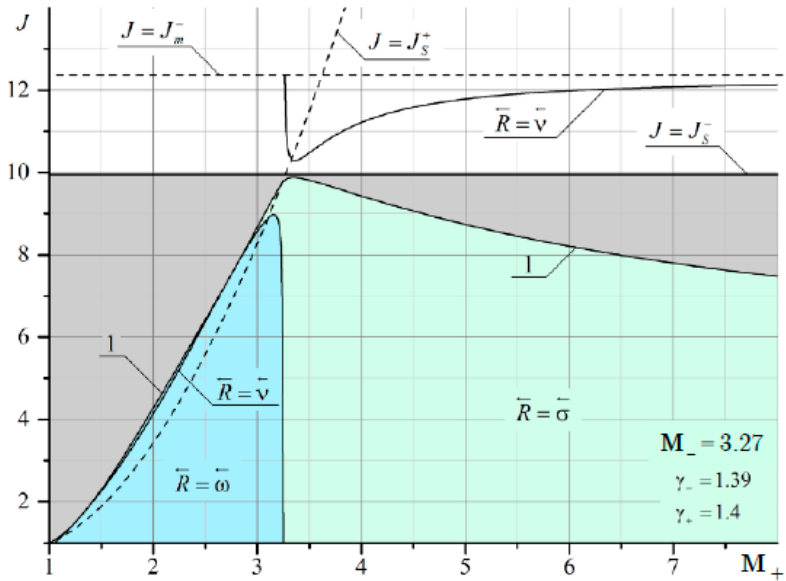
Figure A16. Domains of existence of reflected discontinuities for refraction from a hydrogen/oxygen mixture at Mach number M – = 3.27 corresponding to Chapman–Judge detonation. The domains of existence of reflected discontinuities for refraction from a propane/air/ combustion product mixture at Mach number M – = 5.46 corresponding to Chapman–Judge detonation are shown in Figure A17.